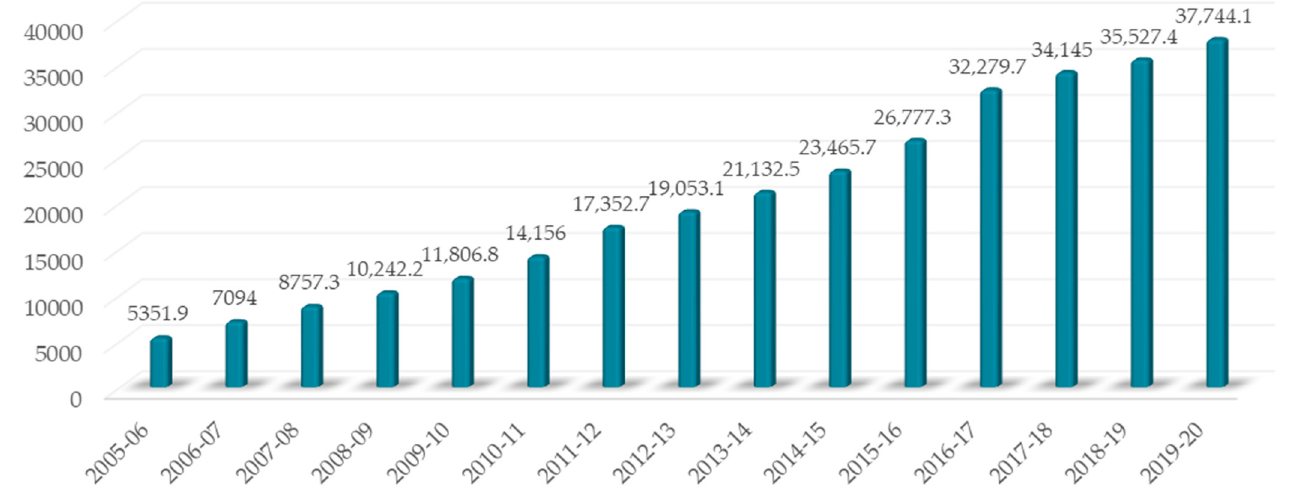
Figure 15. Cumulative installed capacities (MW) of wind turbines from fiscal year 2005–2006 to fiscal Table 16. Comparison of cumulative installed capacities and estimated potential in (MW), by state. Source: Indian Wind Energy Association [60] (as on 31